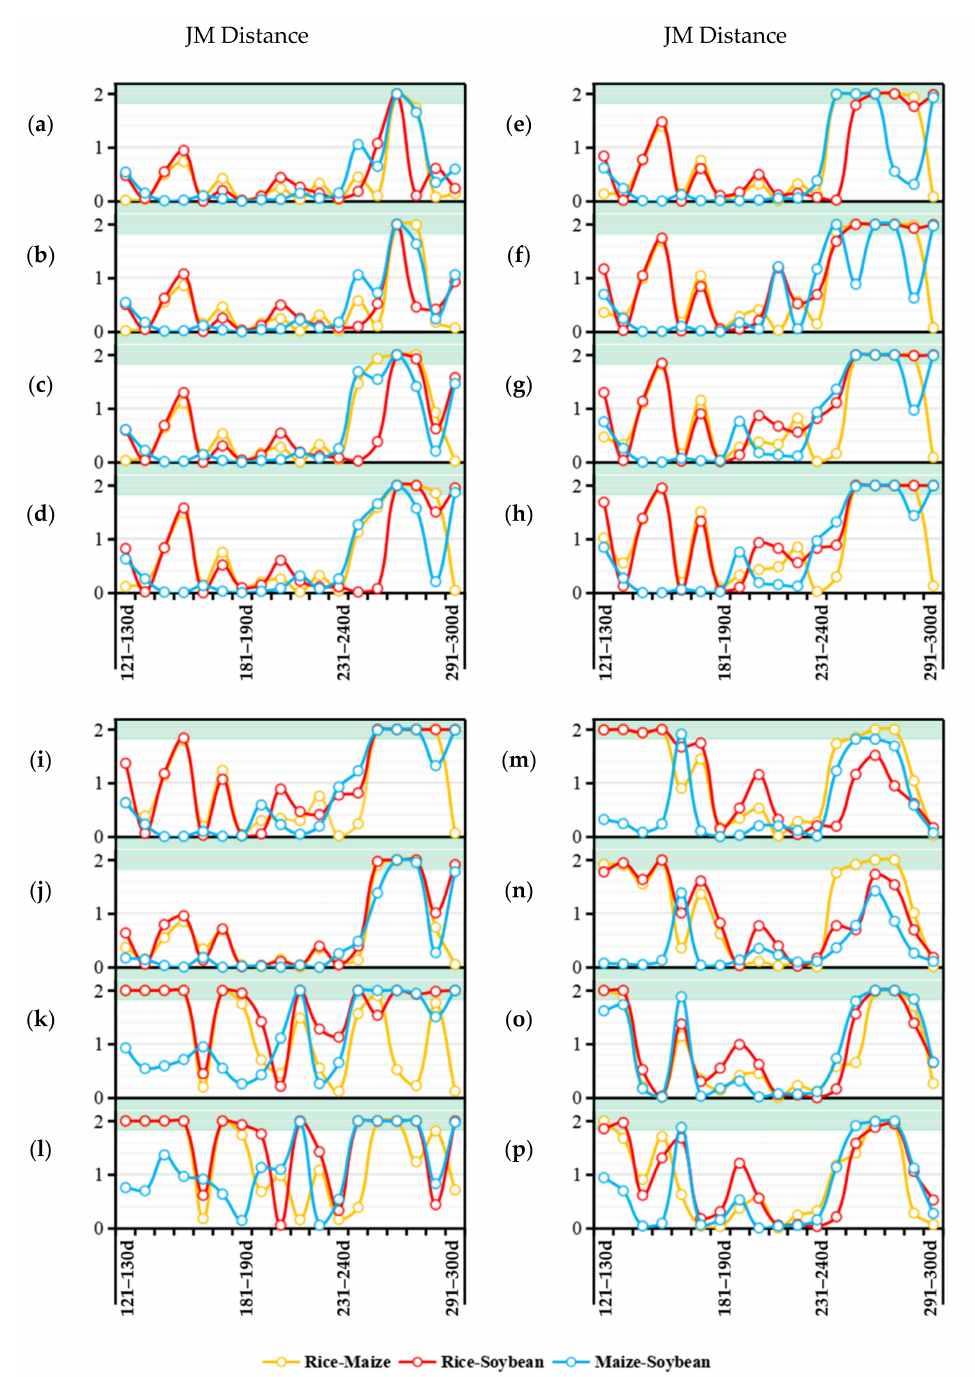
Figure 4. JM distances between crops in the following features: ( a ) B1, ( b ) B2, ( c ) B3, ( d ) B4, ( e ) B5, ( f ) B6, ( g ) B7, ( h ) B8, ( i ) B8A, ( j ) B9, ( k ) B11, ( l ) B12, ( m ) EWI, ( n ) MNDWI, ( o ) NDVI, and ( p )